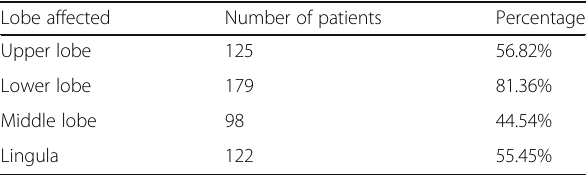
Table 2 Lobar affection Lobe affected